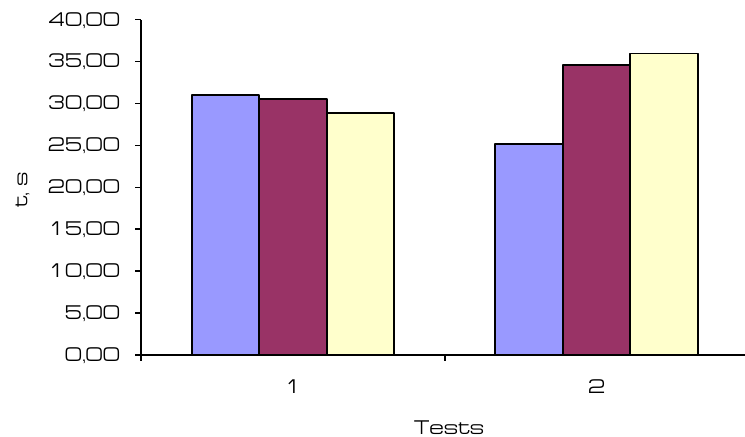
Fig.1. Reproduction of time intervals by elite athletes, specializing in speed climbing (n=10), climbing on complexity (n=10) and mountaineering (n=6): 1 - reproduction of time interval 30 sec, s. 2 - reproduction of time interval of 1 minute,